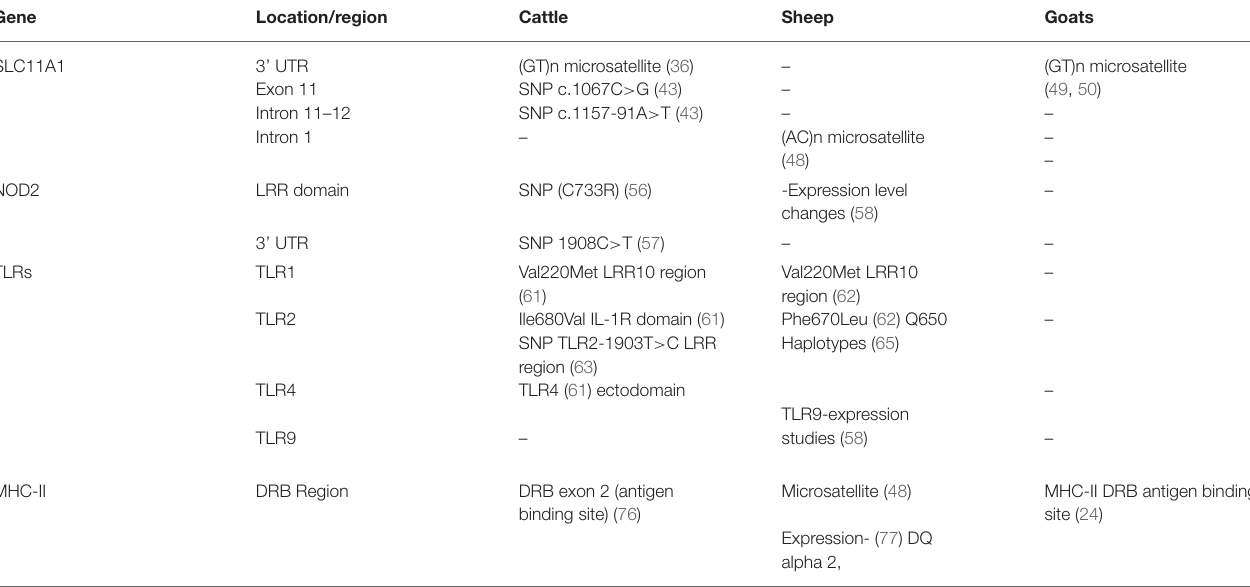
TABLE 1 | Summary Table of evidence of association in MAP infection by candidate gene and species.